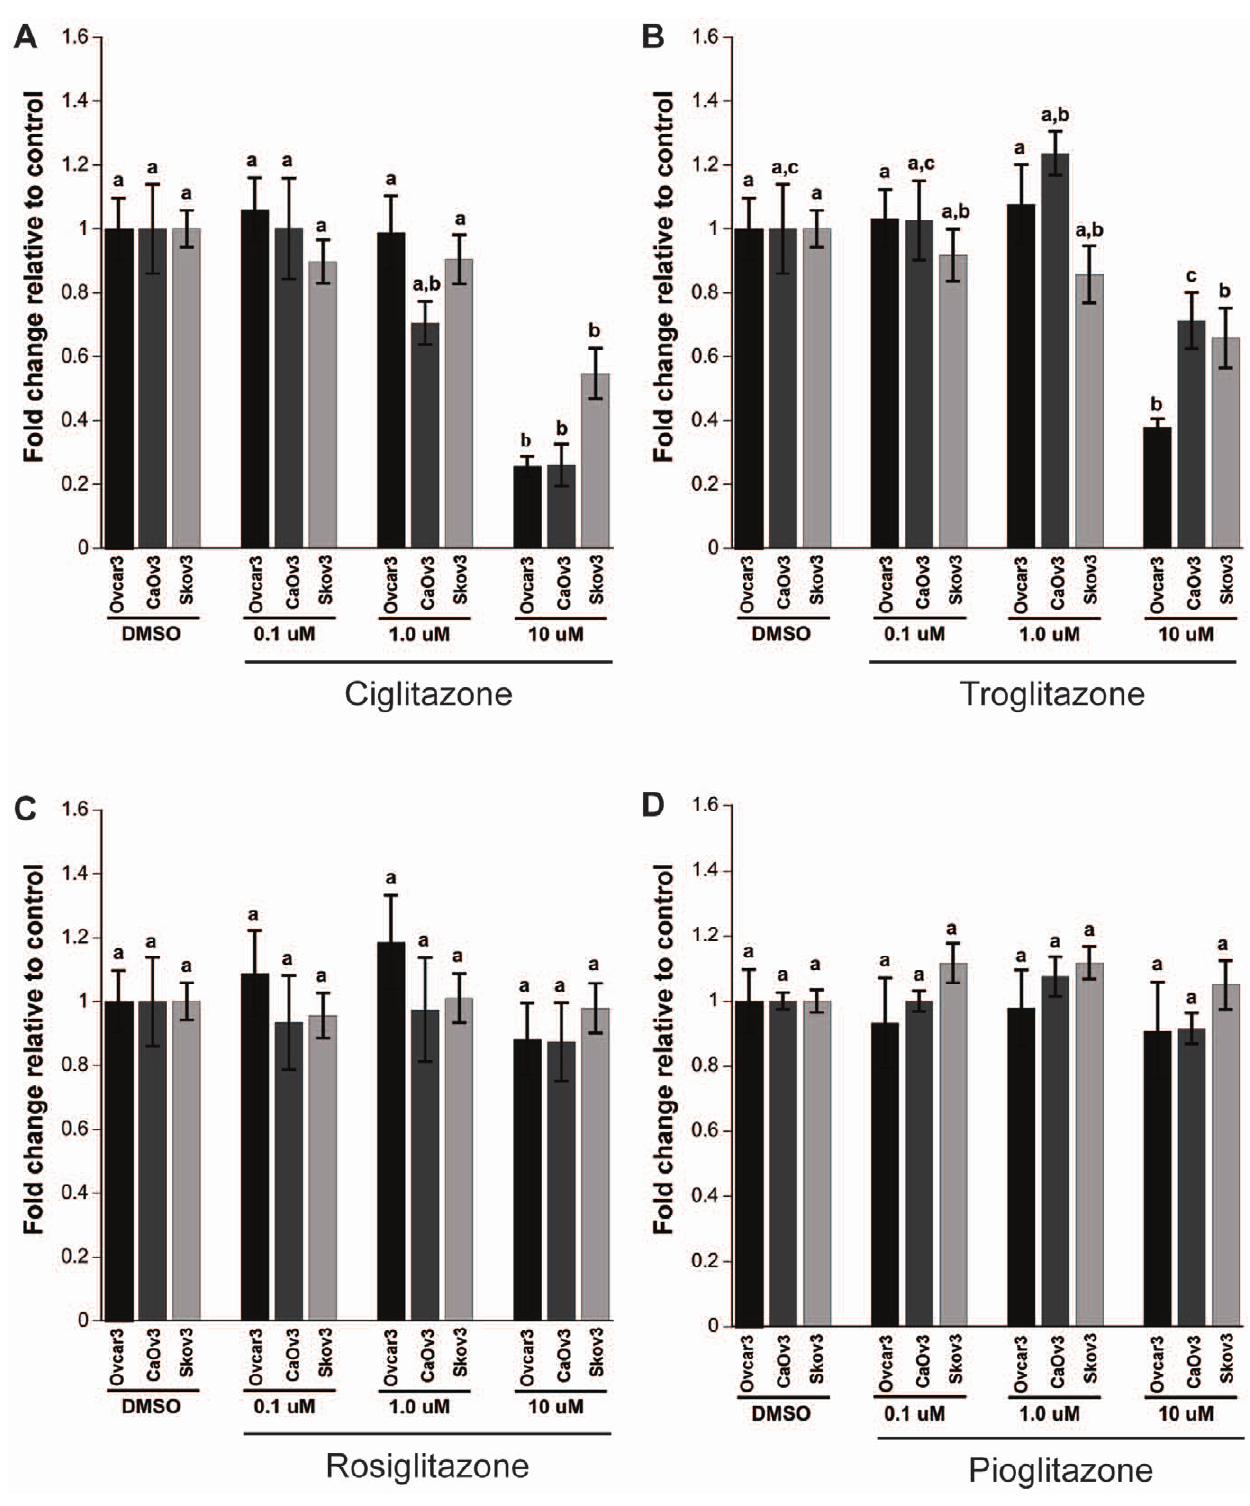
Figure 3. Effect of TZD treatment on Ovcar3, CaOv3 and Skov3 cell proliferation. Ovarian cancer cells were serum starved for 24 hours and treated for an additional 24 hours with vehicle control (DMSO) or 0.1, 1.0 or 10 m M of CGZ ( A ), TGZ ( B ), Rosi ( C ), or Pio ( D ). Cell proliferation was assessed with the MTS assay. Results are the means 6 SEM for at least 3 measurements from three individual experiments. Statistical analysis was performed within each cell line. Bars that do not share a letter designation are significantly different within a treatment group ( p , 0.05). Black bars: Ovcar3, Grey: CaOv3, Light grey: Skov3.